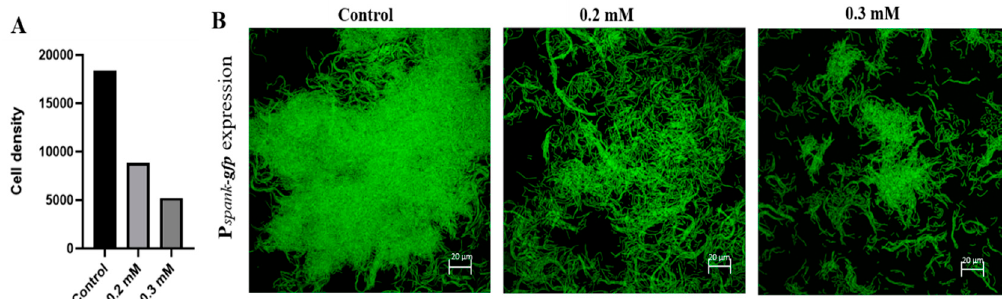
Figure 1. Inhibitory effect of Zn 2+ ions on biofilm formation by B. subtilis . Zinc ions inhibited biofilm bundle formation by the bacterial cells grown in the presence of ZnCl 2 ; Demonstrated by calculation of cells density ( A ) and shown by confocal laser scanning microscopy (CLSM) imaging of fluorescently tagged B. subtilis cells ( B ), following an overnight incubation in Lysogeny broth (LB) supplemented with 3% lactose at 23 °C (with 50 rpm shaking). Scale bar–20 μ m.